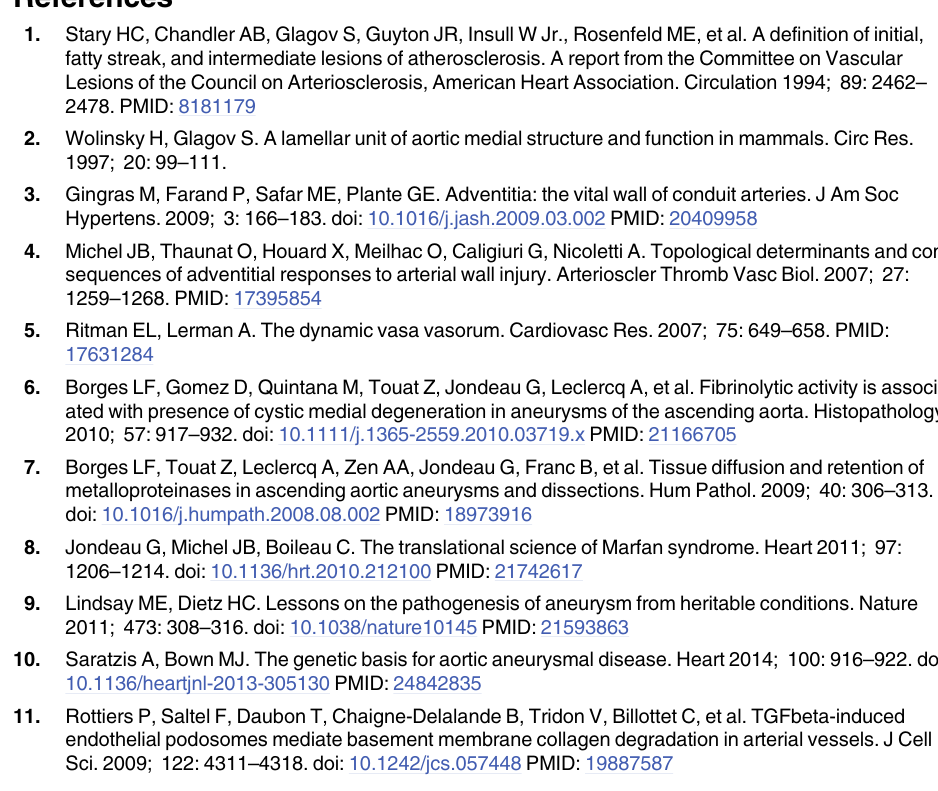
S3 Fig. Validation of EC-enriched fraction selection procedure by vWf staining, regardless the presence or absence of TGFbeta. The graph shows the percentage of cells positive for vWf at P2, with or without TGFbeta treatment, determined by immunofluorescence for 12 patients (IECs and AECs from 5 patients and AECs from two additional patients). p > 0.5.